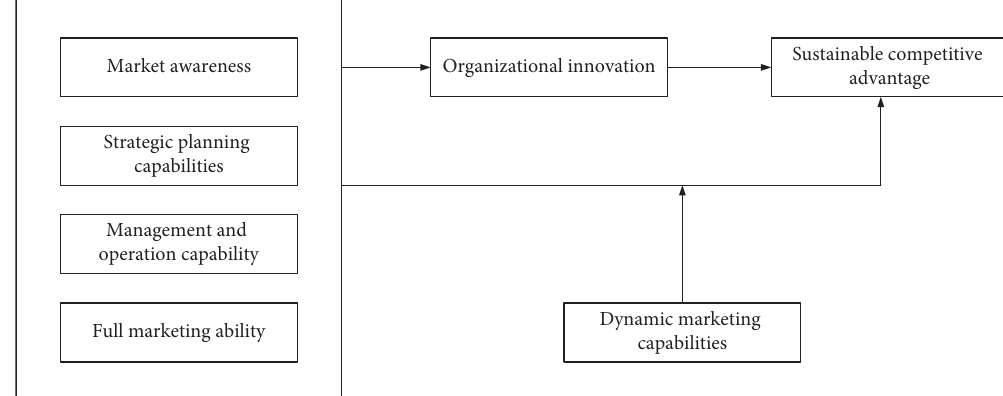
Figure 4: Theoretical model for identifying core marketing capabilities of high-tech enterprises from the perspective of sustainable competitive advantage (after